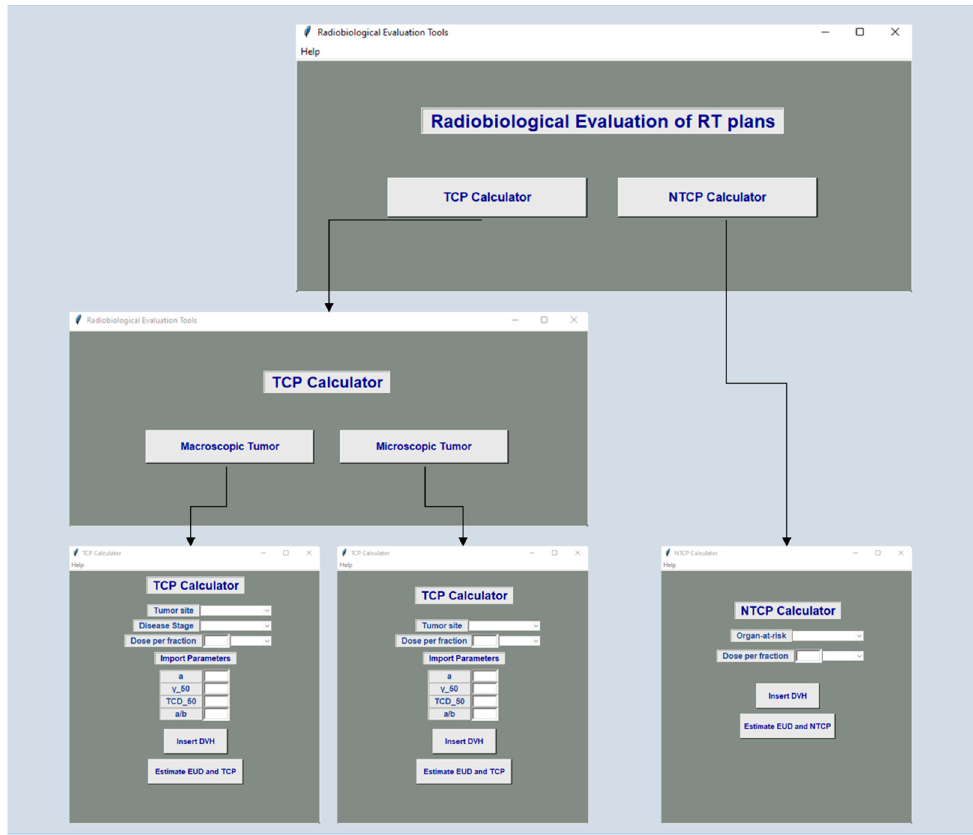
Figure 1. Architecture of the software tool for the radiobiological evaluation of radiation therapy plans.